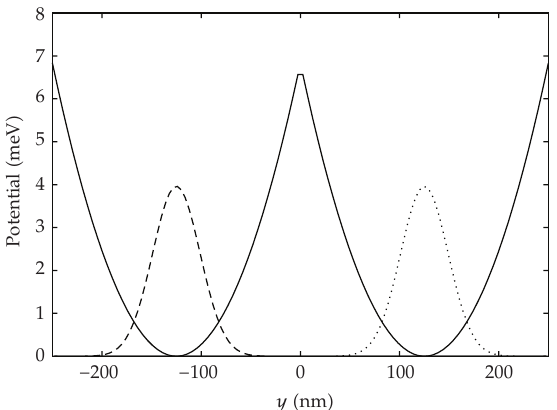
Figure 3: The qubit potential and electron probability density in the two localized computational basis states | 0 (cid:2) and | 1 (cid:2) . The potential and probability densities are modeled in two-dimensions and symmetric about the x -axis; so only the values with x 1 (cid:7) 0nm are shown